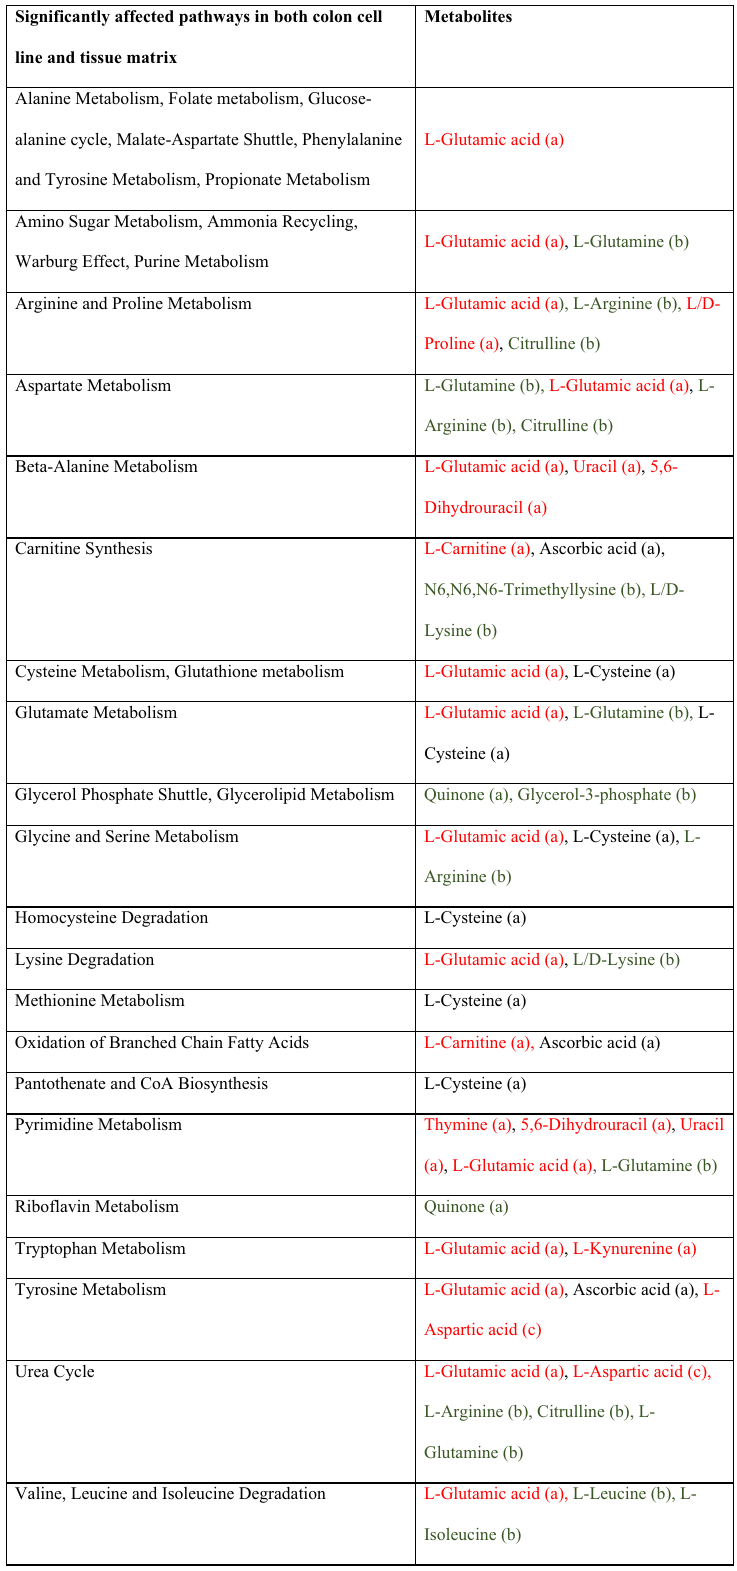
Table 3. Quantitative enrichment analysis in MetaboAnalyst 4.0. Metabolites were upregulated in non- transformed (green) or transformed (red) state and discriminative for both matrices (a), colon cell line (b) or tissue matrix (c). Metabolites that behaved contradictory in colon cell line and tissue samples are presented in